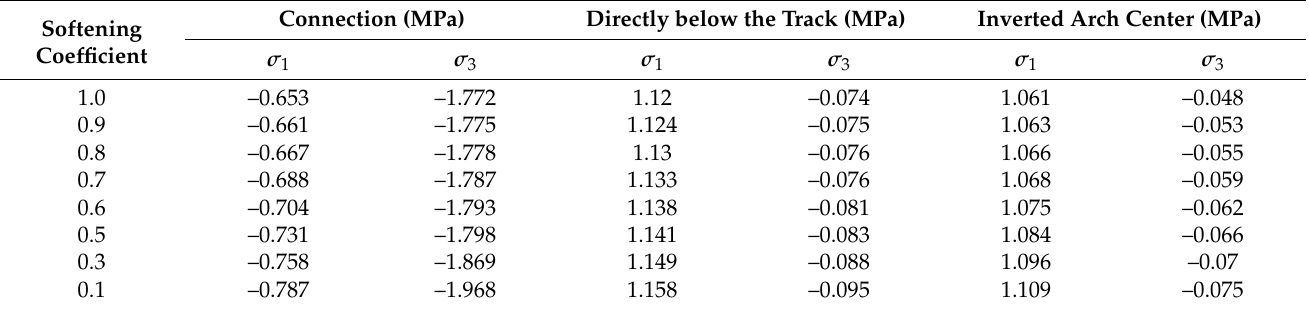
Table 5. Maximum and minimum principal stress of base structure with different softening